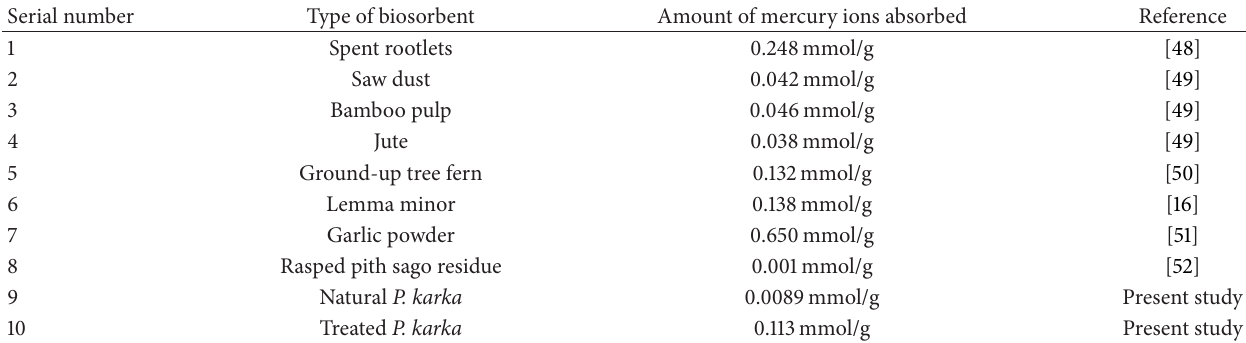
Table 4: A comparison of mercury metal ions adsorbed by different